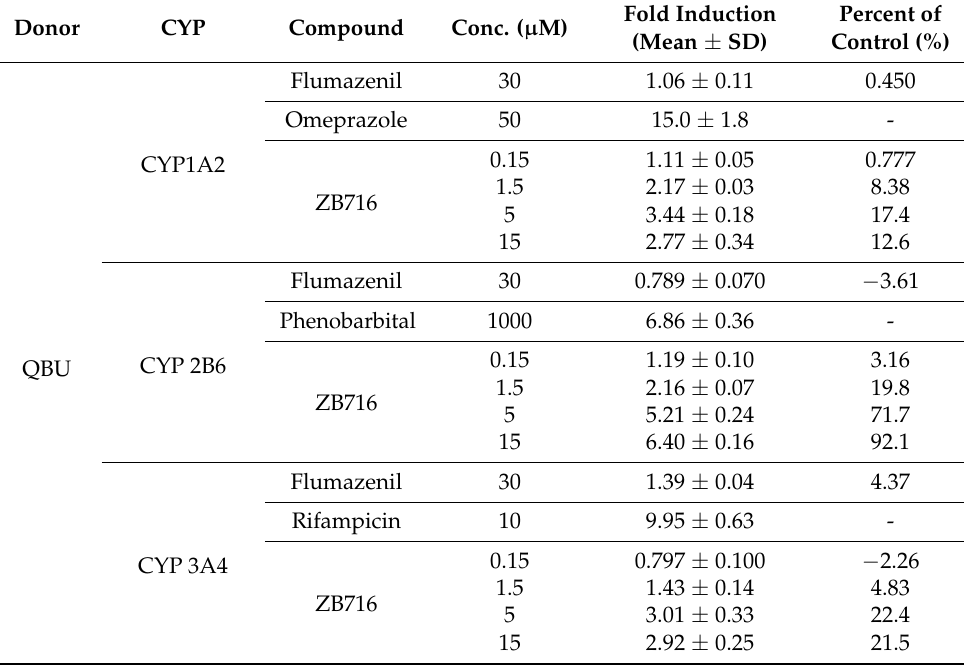
Table 12. Induction potential of ZB716 and positive control based on enzyme activity (mean ± SD, n =